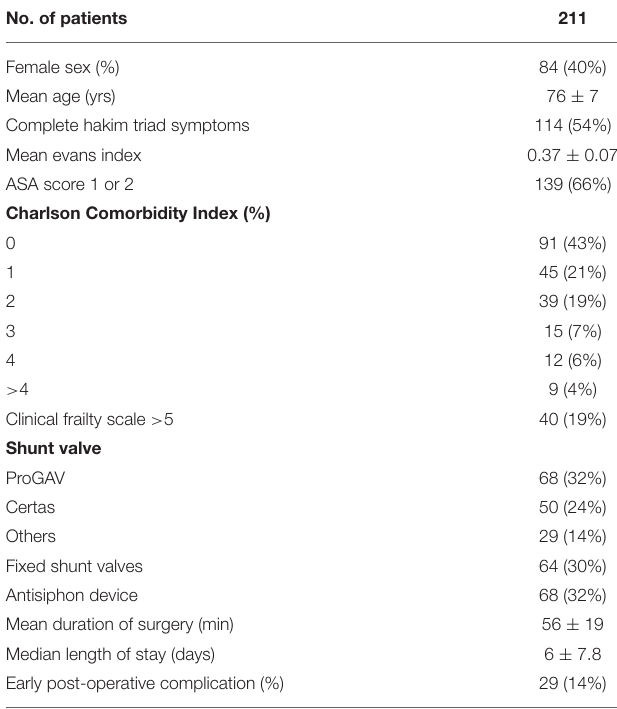
TABLE 1 | Baseline patient characteristics.